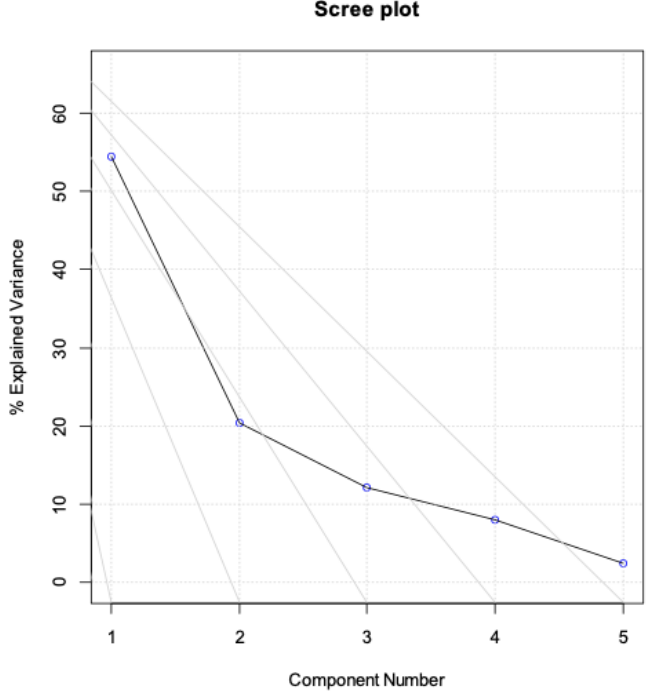
Figure 3. Scree plot of the data set (variance % explained by each component: 54.4; 20.4; 12.2; 8.0; 2.52).